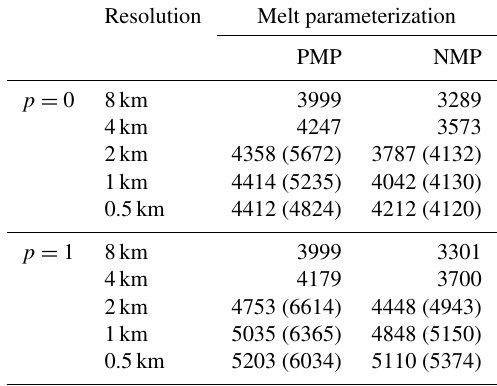
Table 5. Loss in ice mass (Gt) at the end of experiment Ice1r for p = 0 and p = 1 and melt rate parameterizations PMP and NMP. These values can be compared directly to those in Seroussi and Morlighem (2018), Table 3, which are shown here in parentheses. The SEM1 and Tsai parameterizations in Seroussi and Morlighem (2018) are similar to PMP and p = 1, respectively, in CISM. Resolution Melt